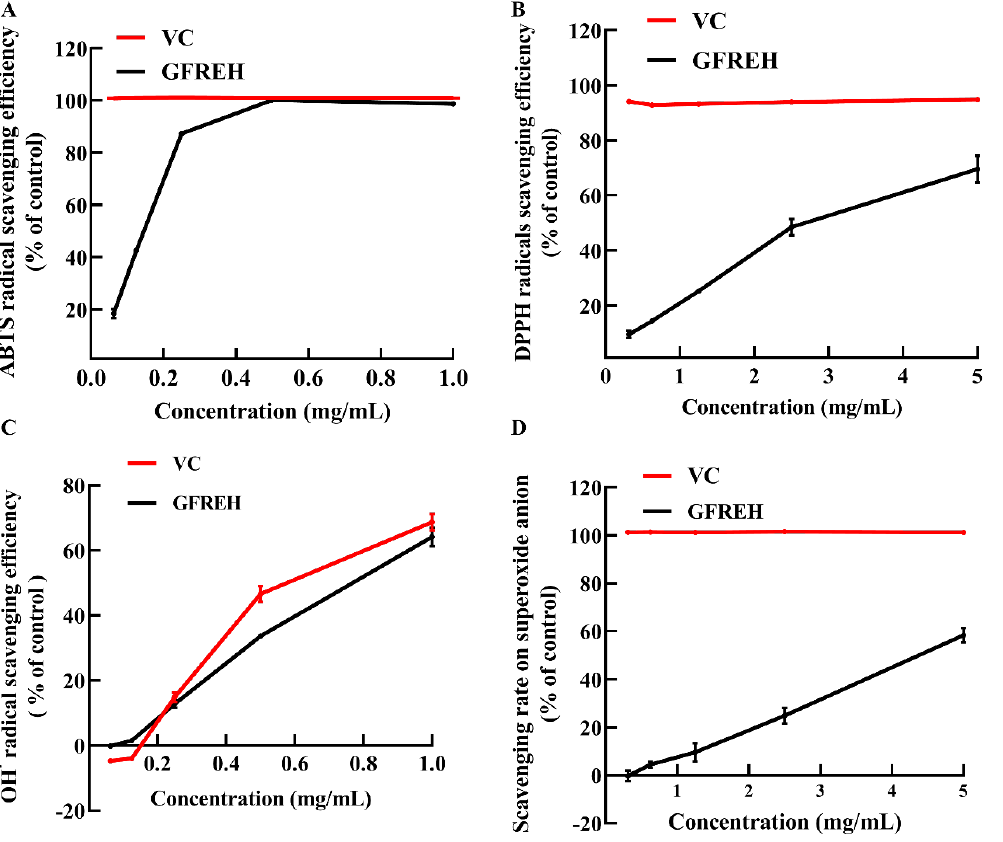
Figure 2. The role of GFREH in the scavenging of free radicals. ( A ) GFREH effectively scavenged ABTS free radicals in vitro (n = 3). ( B ) GFREH greatly scavenged DPPH free radicals in vitro (n = 3). ( C ) GFREH effectively scavenged OH · free radicals in vitro (n = 3). ( D ) GFREH effectively scavenged superoxide anion in vitro (n =